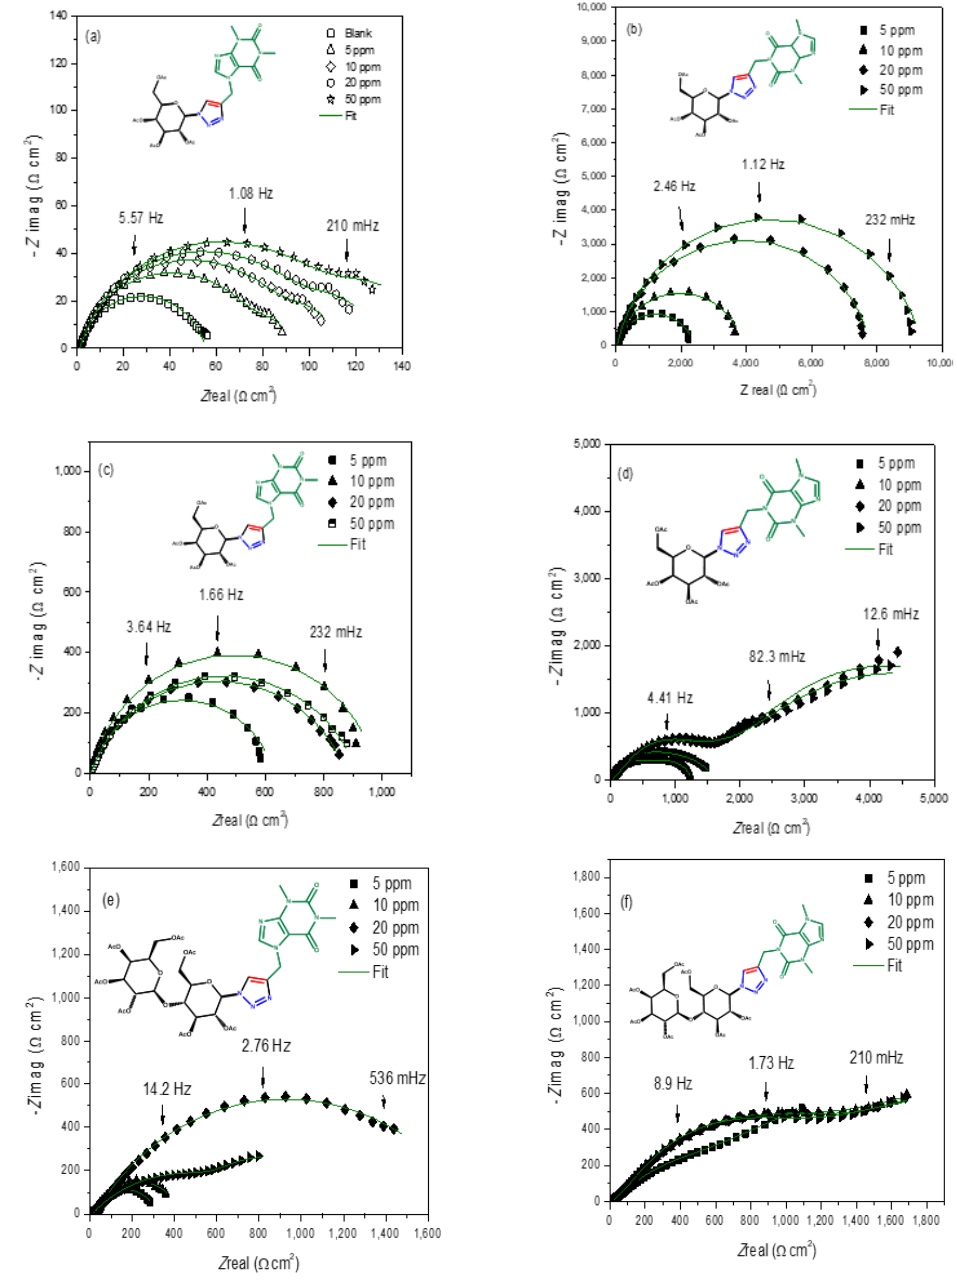
Figure 2. Nyquist diagram at different inhibitor concentrations ( a ) compound 3a , ( b ) Compound 3b, ( c ) compound 3c, ( d ) Compound 3d, ( e ) compound 3e and ( f ) compound 3f in API 5L X70 steel immerse in HCl 1